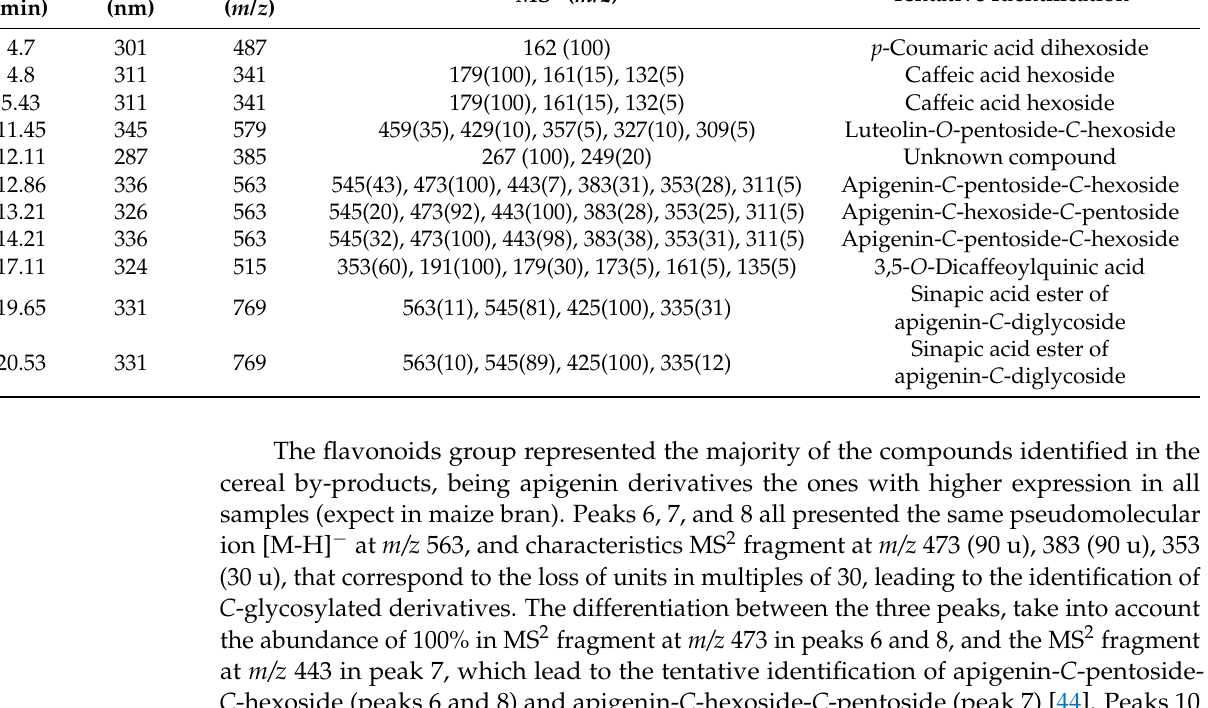
Table 4. Phenolic compounds tentatively identified in the hydroethanolic extracts of the cereal by-products. It is presented the retention time (Rt), wavelengths of maximum absorption in the visible region ( λ max ), and mass spectral data.